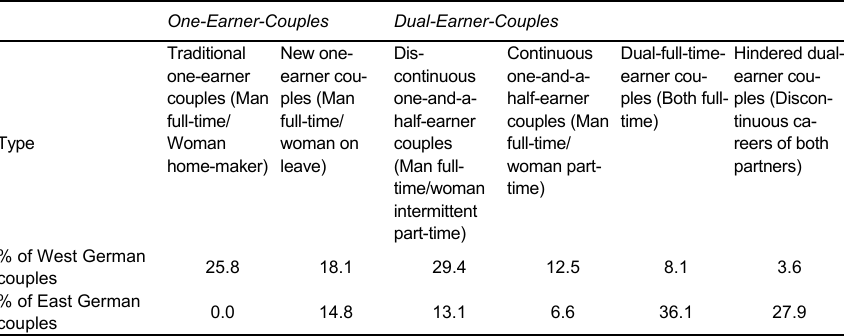
Table 4 Employment Constellations among Young Parents after Birth of a First Child in West and East Germany, 1990-2002 (N=302); no data available for the United States)